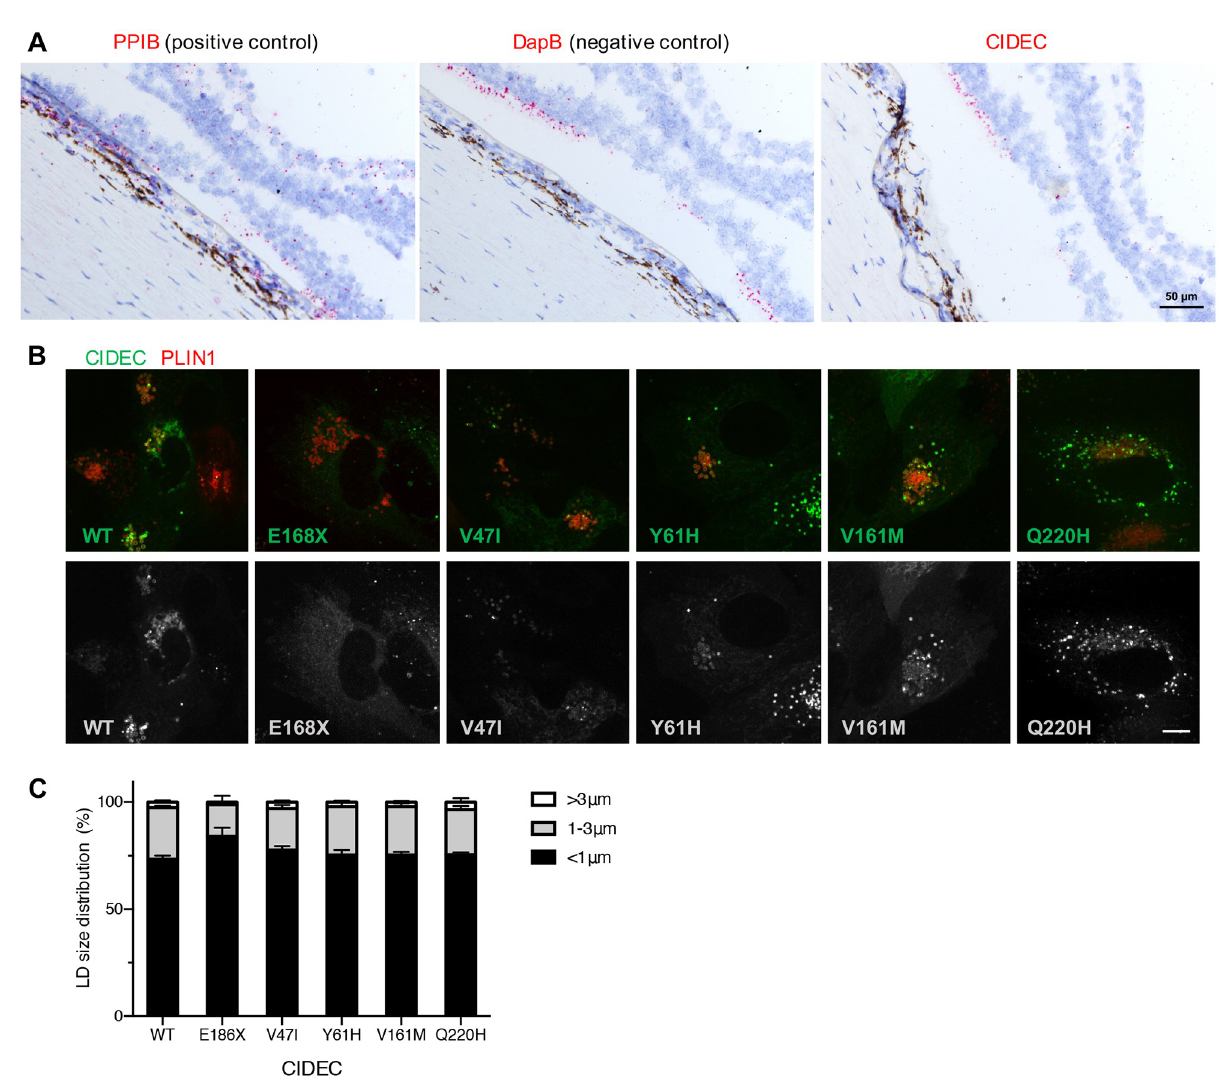
Fig 7. CIDEC RNA is not detected in the human eye and exogenous expression of the CIDEC variants does not affect lipid droplets (LDs) size in Retinal Pigment Epithelium (RPE) cells. (A) In situ hybridization in the fovea of a control human donor eye showing that CIDEC RNA is not detected in the retina or RPE cells. Detection of PPIB (red) was used as positive control and detection of bacterial DapB was used as negative control and evaluation of the non-specific background. Scale bar: 50 μ m. (B and C) Human fetal RPE cells were co-infected with lentivirus expressing CIDEC variants and PLIN1 as marker for LDs. The infected cells were differentiated for 3 weeks before oleic acid stimulation. Representative images of RPE cells expressing both CIDEC variants and PLIN1 (B). LD diameters were quantified by diameter range as depicted in the bar graph (n = 3; mean ± SD) (C). Scale bar: 5 μ